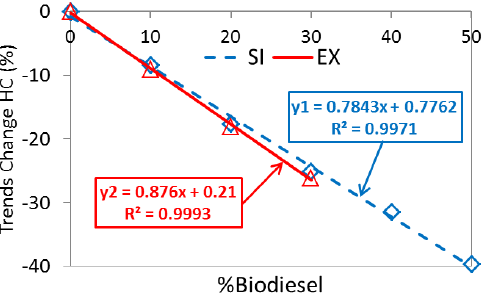
Figure 15. Trend of changes HC emissions according to biodiesel blend ratio of simulation (SI) and experiment (EX).